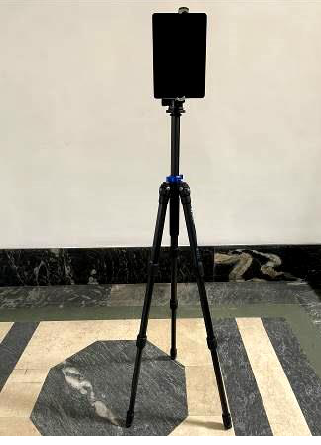
Figure 1 . Static configuration of the iPad mounted on a tripod to acquire the white vertical wall.